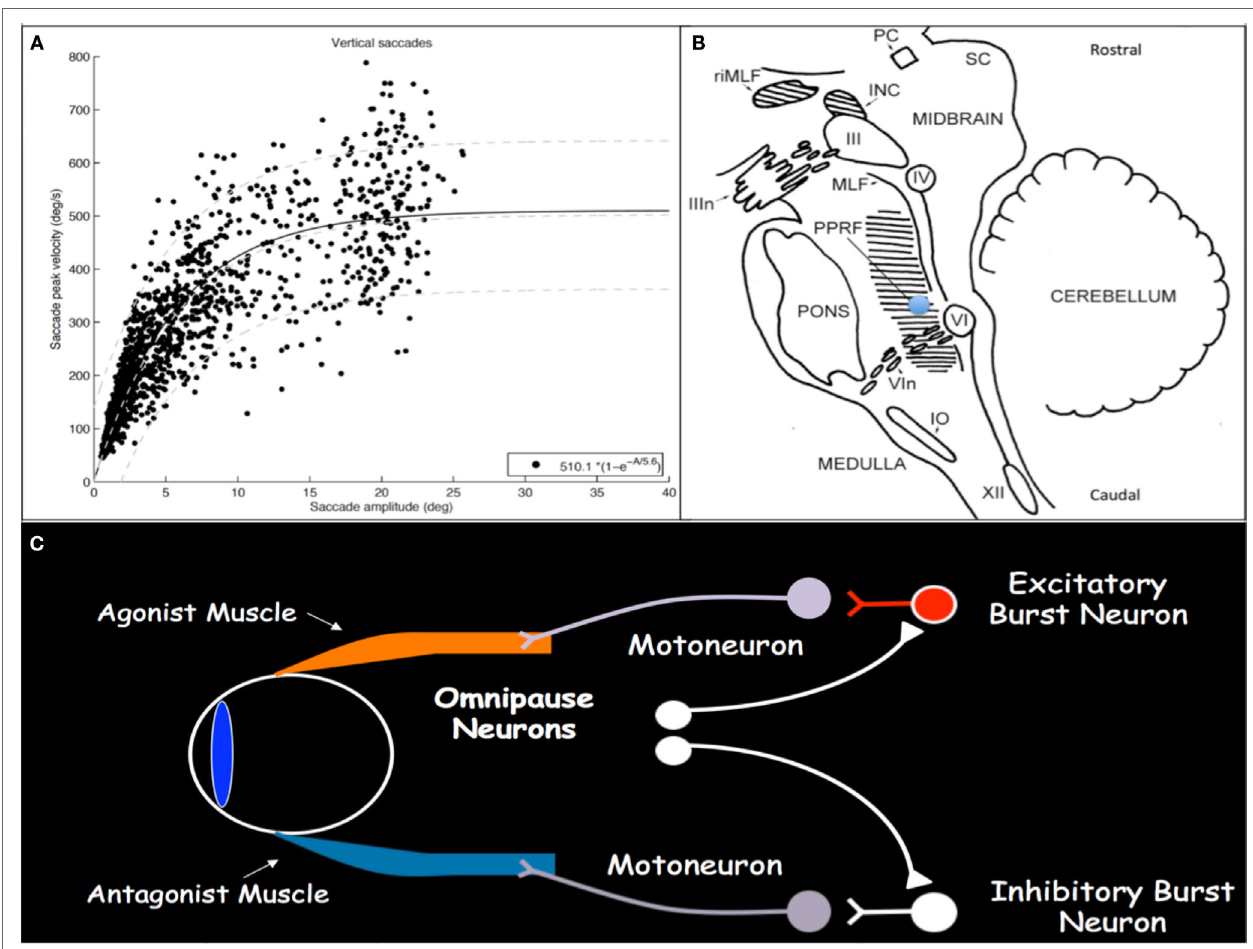
FiGuRe 1 | (A) Main sequence plot for vertical saccades, representing the relationships between saccade amplitude and peak velocity, in a cohort of patients with concussion demonstrating normal saccadic velocities. As saccade amplitude increases, peak velocity increases in an asymptotic distribution. Light gray lines represent the 5th, 50th, and 95th percentiles, respectively, from bottom to top, in healthy disease-free controls. (B) Sagittal brainstem drawing showing the localization of ocular motor-related nuclei. Supranuclear burst neurons for vertical saccades are located in the midbrain in the RIMLF. The shaded region in the pons represents the PPRF, containing supranuclear burst neurons for horizontal saccades. Excitatory burst neurons are located in the region of the blue circle. Abbreviations: PC, posterior commissure; RIMLF, rostral interstitial medial longitudinal fasciculus; INC, interstitial nucleus of Cajal; SC, superior colliculus; IIIn, oculomotor nerve fascicle; III, oculomotor nucleus; IV, trochlear nucleus; MLF, medial longitudinal fasciculus; PPRF, paramedian pontine reticular formation; VI, abducens nucleus; VIn, abducens nerve rootlets; IO, inferior olive; XII, hypoglossal nerve. Drawing based on Buttner and Buttner-Ennever (6). (C) Schematic drawing of excitatory and inhibitory burst neurons, omnipause neurons, and their connections with agonist and antagonist extraocular